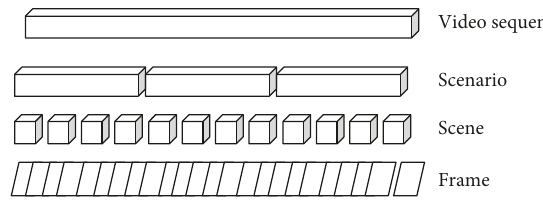
Figure 1: Hierarchical structure of